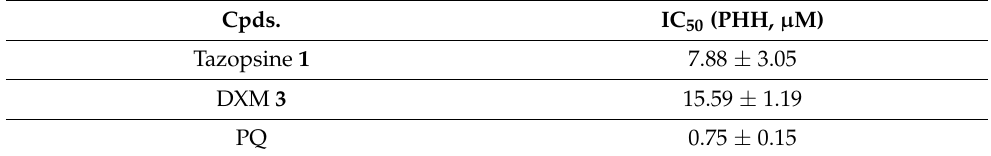
Table 3. In vitro IC 50 values of tazopsine 1 and DXM 3 in P. falciparum liver stages. IC 50 values are the mean of four technical replicates. PHH, primary human hepatocytes; PQ, primaquine. Cpds.